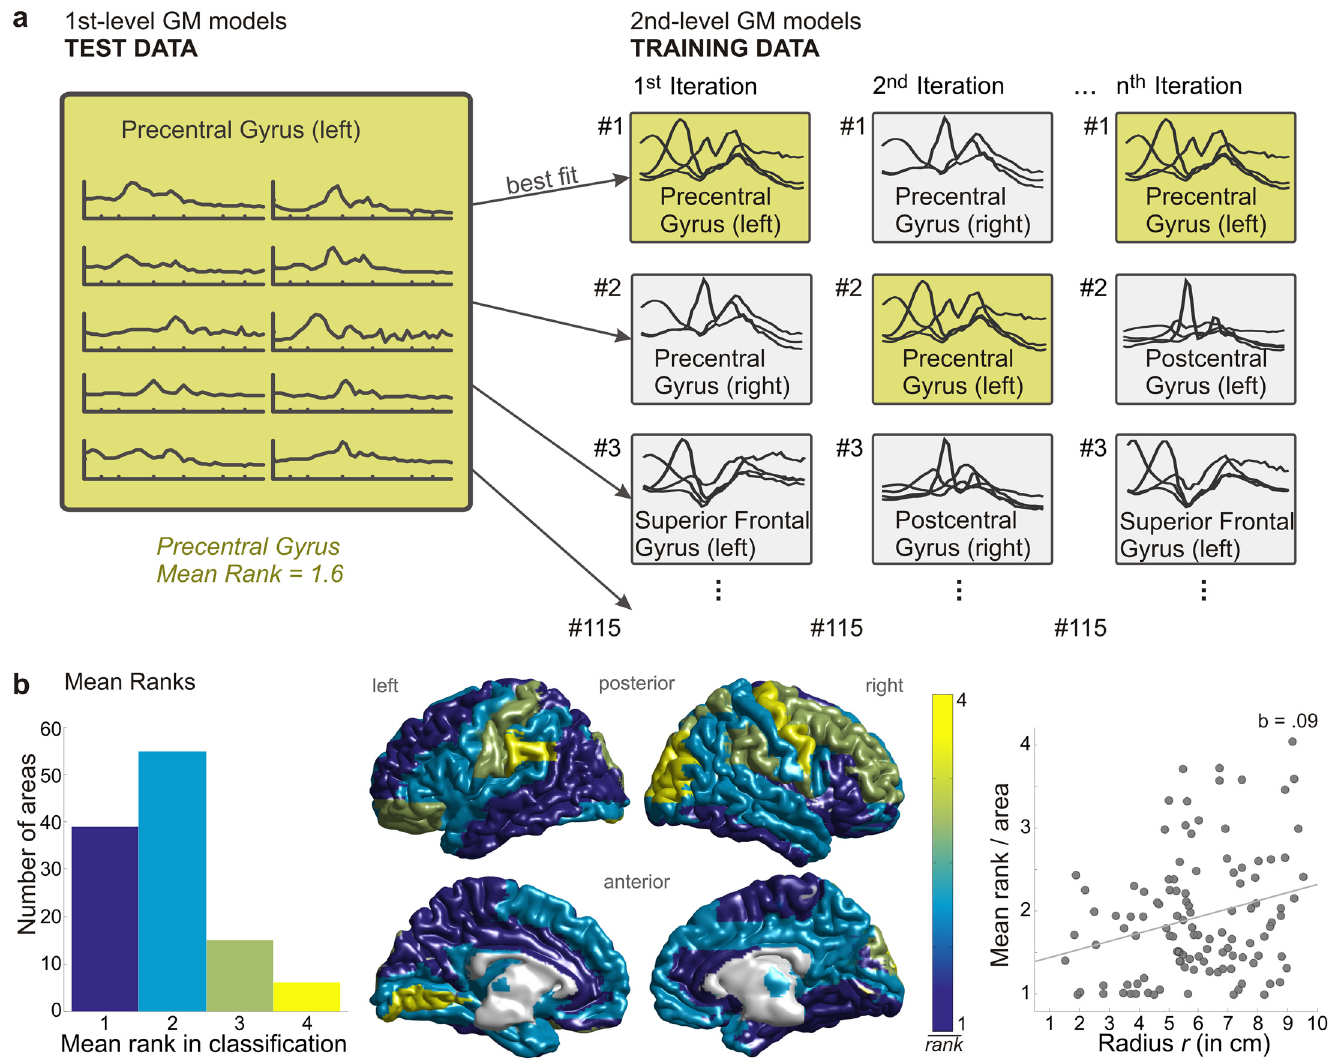
Fig 3. Classification procedure and results. a) Illustration of classification procedure. Second-level GM training models were created for all brain areas with data from half of the sample (group-level, right panel). Area-specific first-level GM test data from the remaining sample (subject-level, left panel) were then tested against each area-specific GM training model. The fit of each test set to each GM training model (determined through negative log-likelihood) was ranked. This was repeated 120 times, and the position of the correct area was averaged across iterations. For the illustrated example, the mean rank equalled 1.6 across 120 iterations. b) Distribution of mean ranks in classification. (left) Histogram of mean ranks across all 115 brain areas. Bin width is one. (middle) Topography of mean ranks (colour-coded from 1, blue, to 4, yellow; bin width is one). (right) Linear regression revealed a dependency of mean rank per area and the radius r from the centre of the brain. The mean rank increases the further an area is away from the centre of the brain. In other words, areas closer to the centre of the brain are easier to classify than more superficial areas. Data underlying this plot can be found in S1 Data.